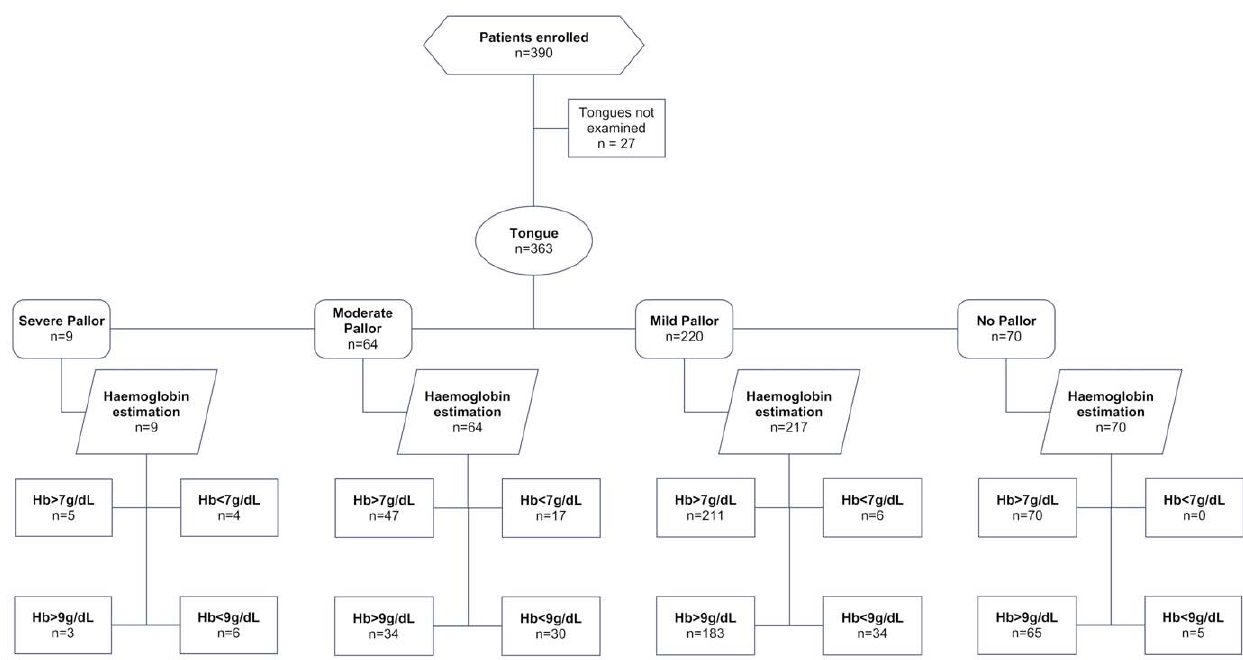
Figure 1. Sample Study Profile, tongue pallor as index test and haemoglobin levels (less than 7 g/dL and 9 g/dL) as reference standards.